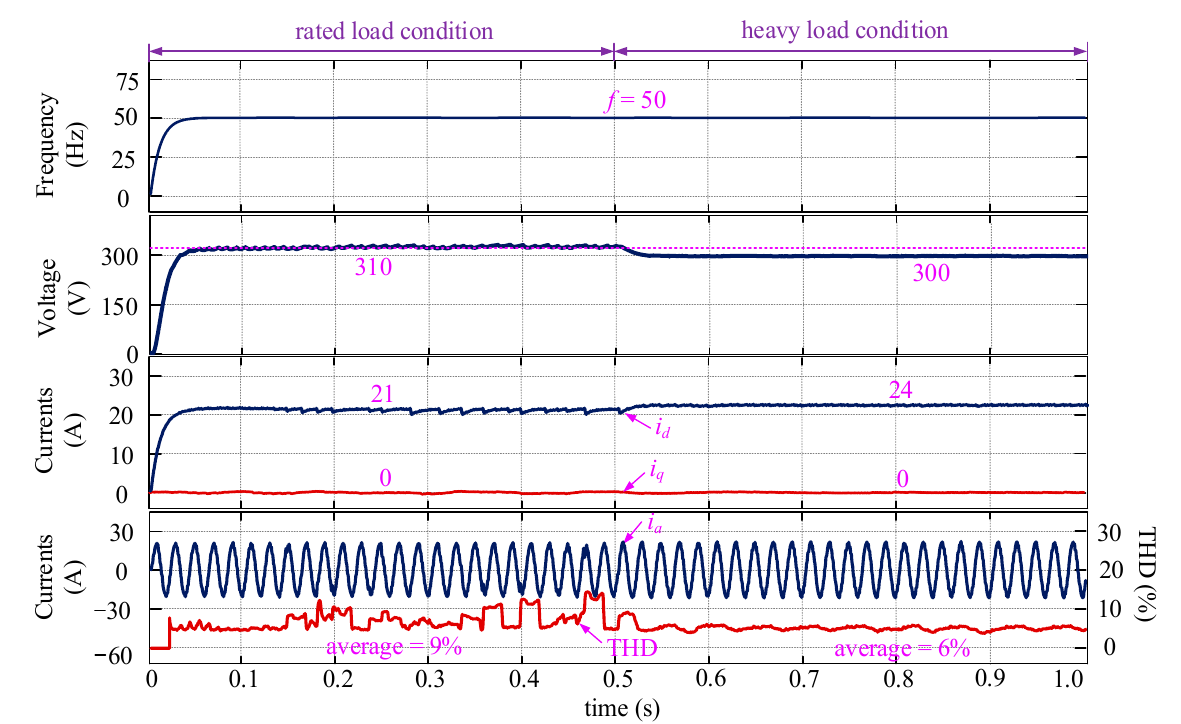
Figure 13. Control performance of the proposed DCL method with parameter mismatch considered (the SMDO does not work, L f_mea = 4 L f , L l_mea = 3 L l , R f_mea = 0.5 R f , R l_mea = 0.3 R l ).